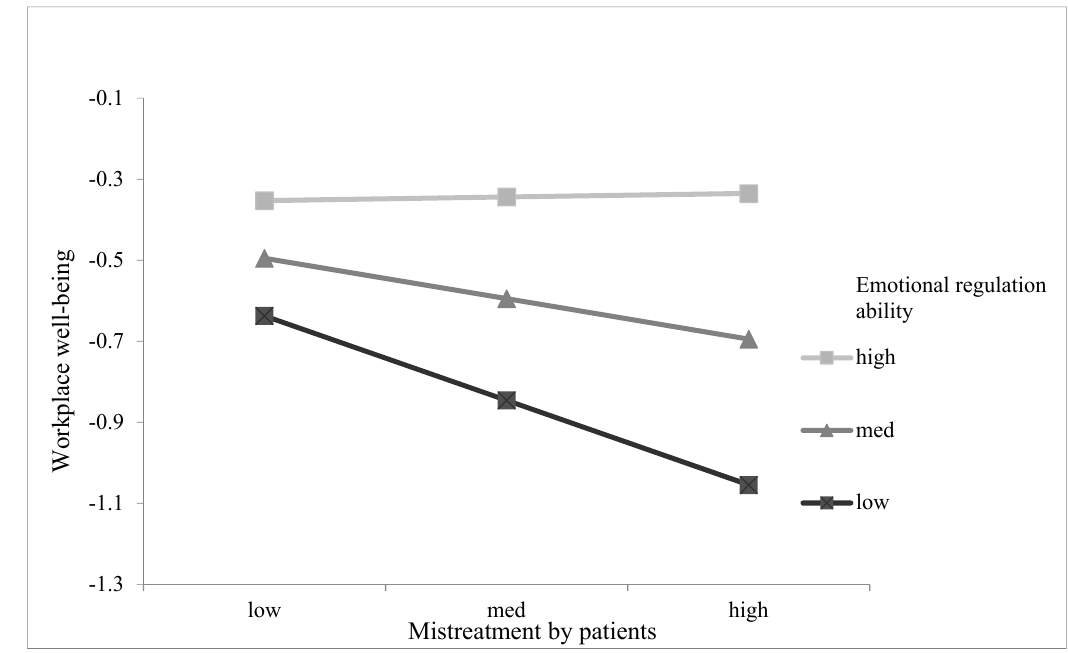
Figure 3. Interaction between mistreatment by patients and emotional regulation ability on workplace well-being.